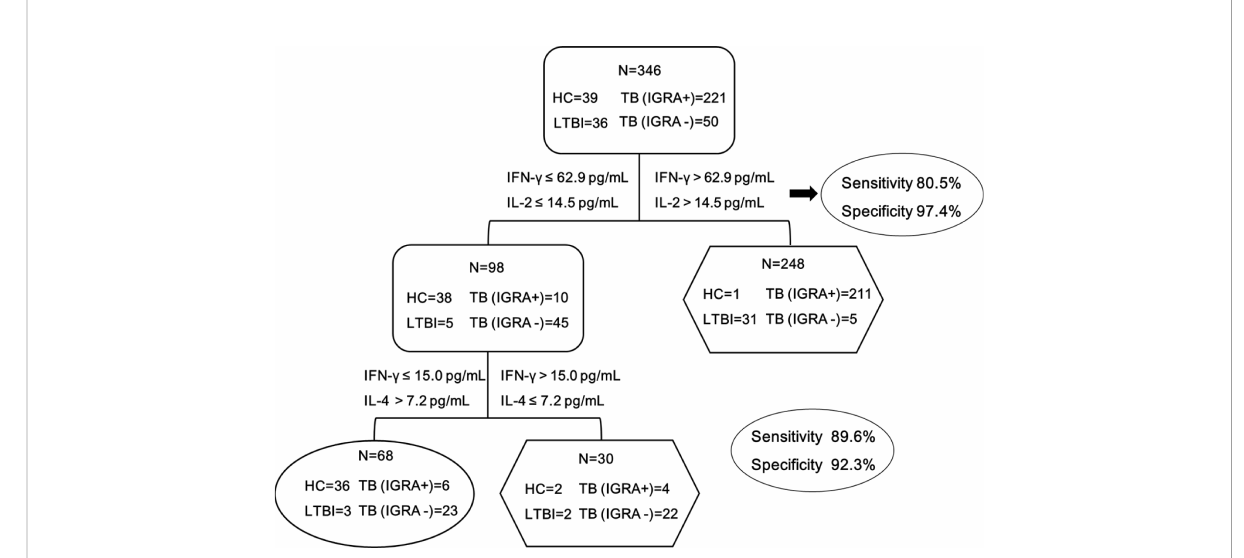
FIGURE 4 The combination of IFN- g &IL-2 and IFN- g &IL-4 provides the best discrimination between HC and MTB infection groups. MTB infection group was de fi ned as TB (IGRA+) patients, TB (IGRA-) patients, LTBI group, while HC group was de fi ned as the control for analyzing the diagnostic performance of the biomarkers. Diagnostic strategy and optimum cut-offs of IFN- g 、 IL-2 and IL-4 were decided by ROC analysis. The sensitivity and speci fi city of the IFN- g &IL-2 and IFN- g &IL-4 panel were 89.6% and 92.3% respectively. TB (IGRA+) group, n=221; TB (IGRA-) group, n=50; LTBI group, n=36; HC group, n=39. Oval and hexagon showed the number fi nally determined as HC and MTB infection, respectively.